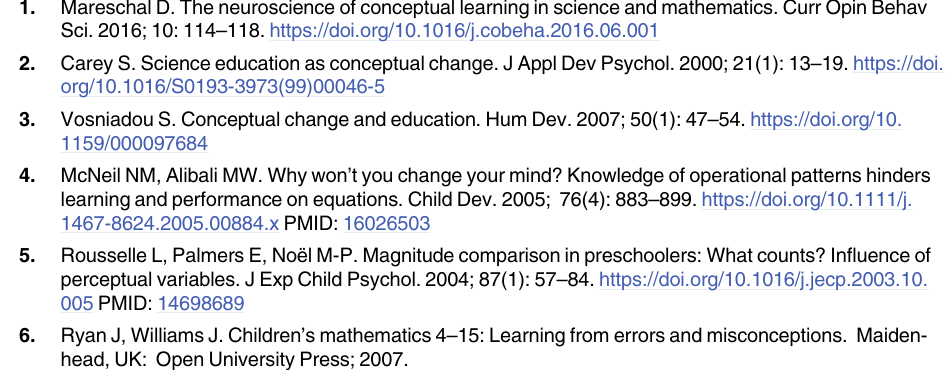
S1 File. Inhibitory control and counterintuitive science and maths reasoning in